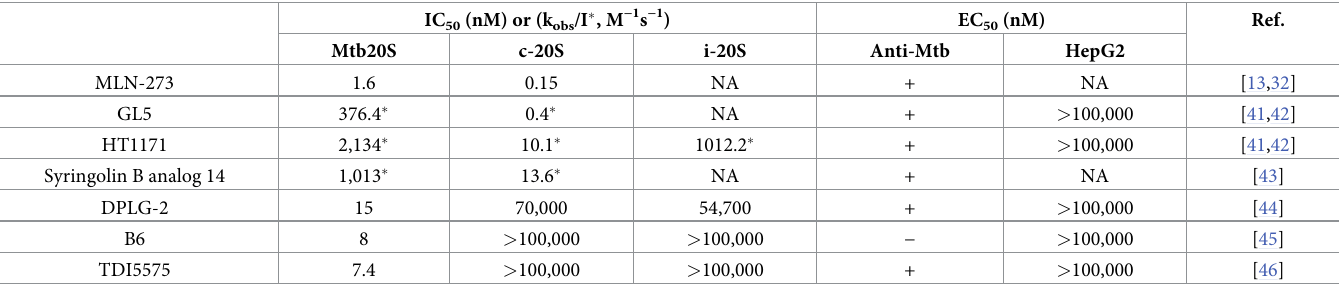
Table 1. Inhibitory activity of Mtb20S